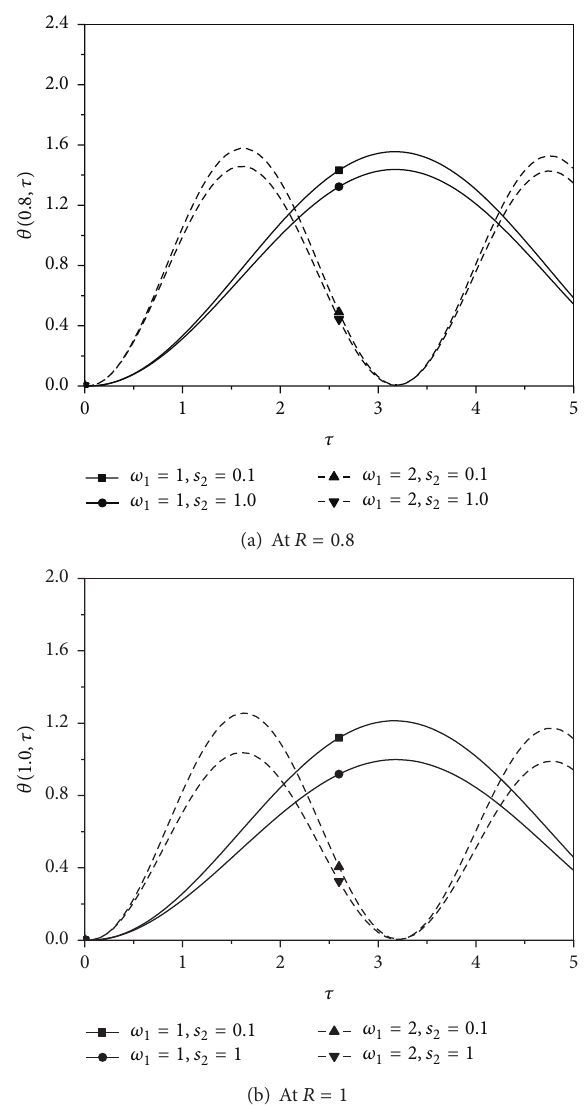
Figure 5: Influence of 𝜔 1 parameter and 𝑠 2 parameter on the temperature variation of the hollow cylinder at middle and right surfaces, [ 𝜓(𝜏) = 1 − cos 𝜔 1 𝜏 , Bi (𝜏) = 2 − 𝑒 −𝑠 2 𝜏 , 𝜃 0 =